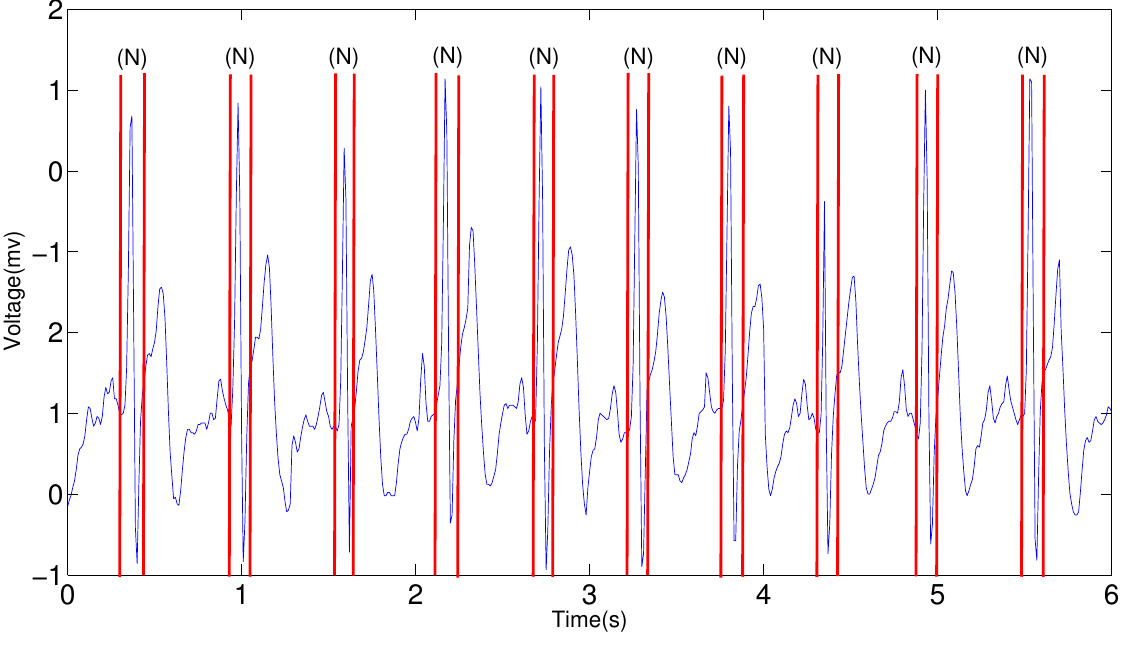
Figure 18. ECG analysis for the wearable ECG sensor node. All the normal beats are annotated as “N”.